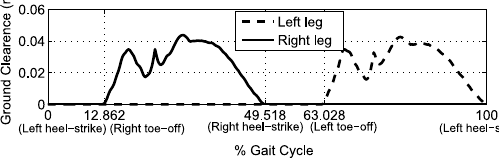
Fig. 10. Ground clearance during gait